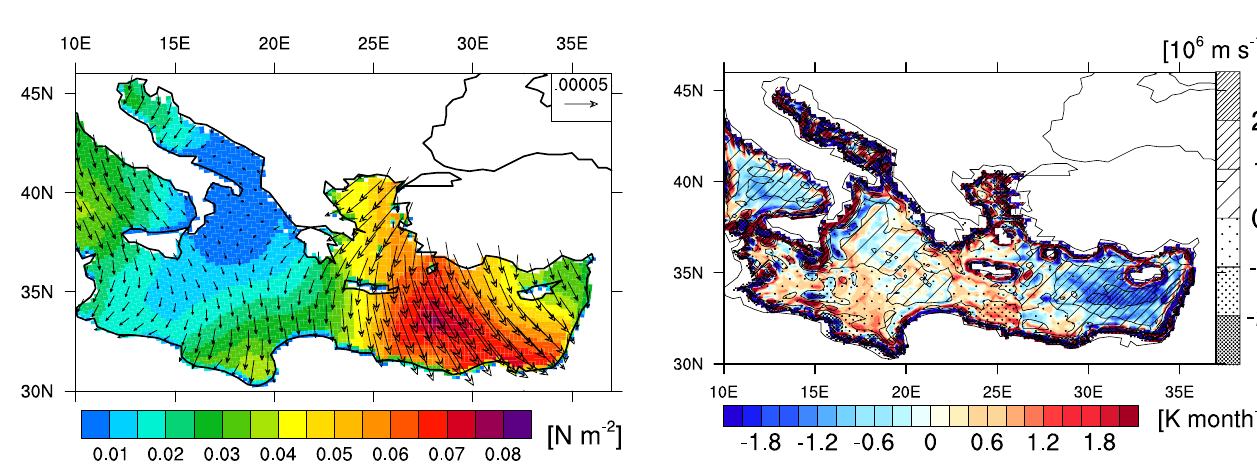
Fig. 14. Mean summer (JAS) wind stress for CTRL.